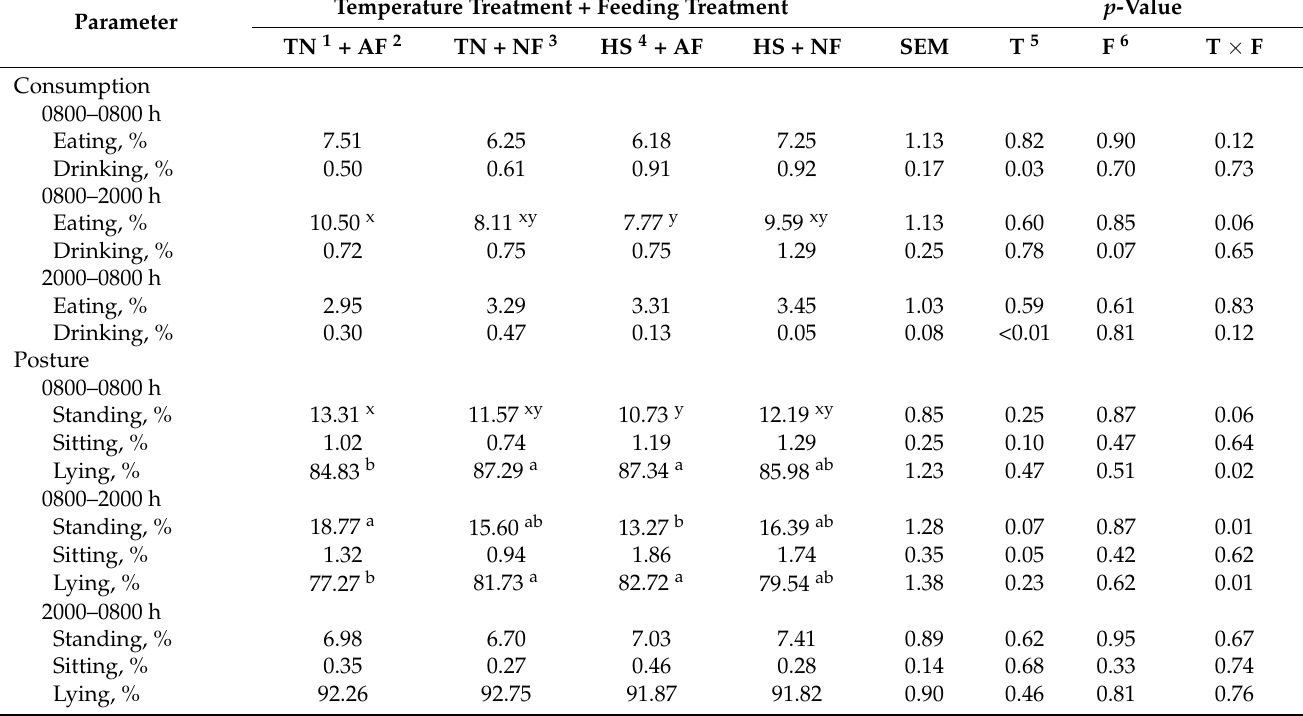
Table 5. Consumption behavior and posture measured on Days 1, 2, 4, 5, and 6 of post-temperature-and-feeding-treatment period in finishing